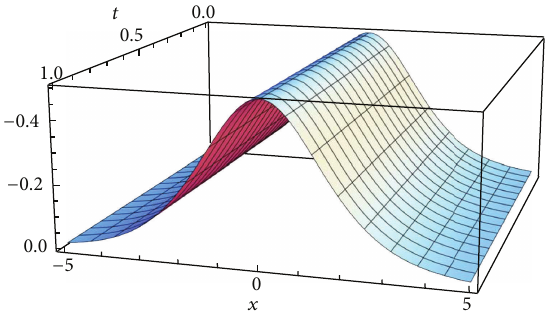
Figure 2: The ℎ -curves according to 10th-order approximation. Dashedpoint: 𝑢(0.01, 0.01) ,solidline: ̇𝑢(0.01, 0.01) ,anddashedline: ̈𝑢(0.01, 0.01) . with 𝑢 ( 𝑥, 0 ) = 0 for 𝑚 > 𝑚